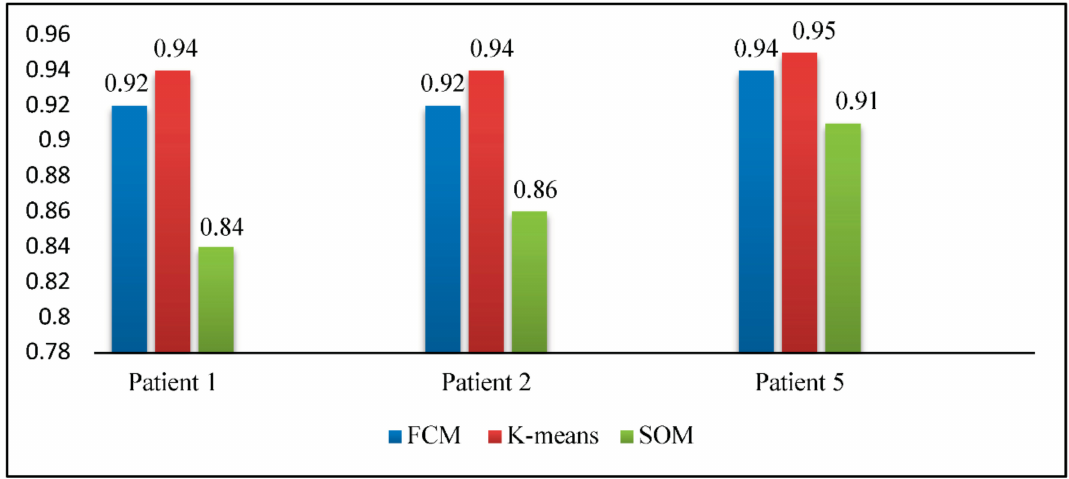
Figure 8. The average SW obtained by FCM, K-means, and SOM algorithms for Patients 1, 2, and